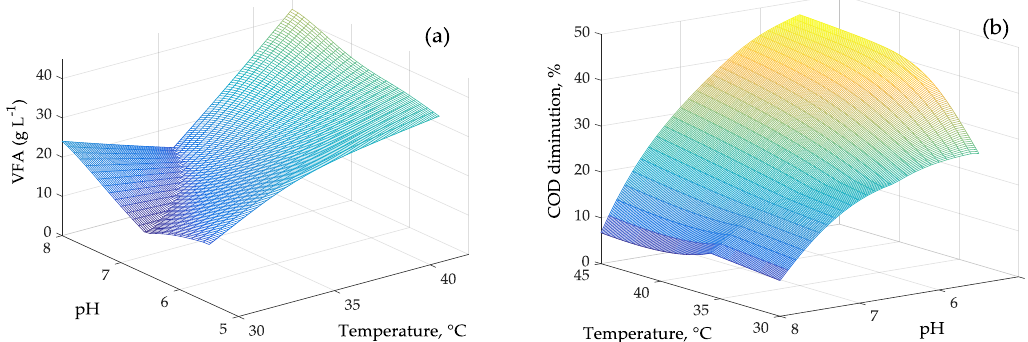
Figure 6. Numerical simulation of the proposed model in the interval of 5 < pH < 8 and 30 < T < 45, ( a ) VFA production and ( b ) COD diminution (%).